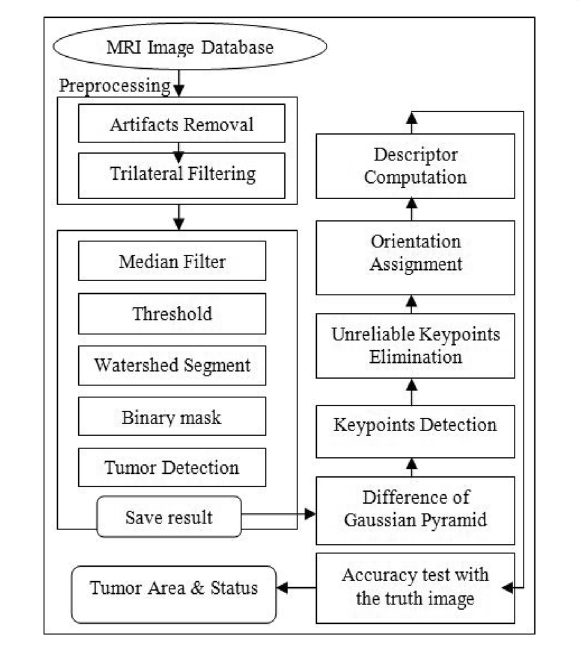
Fig. 2 Block diagram of the watershed-matching algorithm. The complete paper is expounded on the above